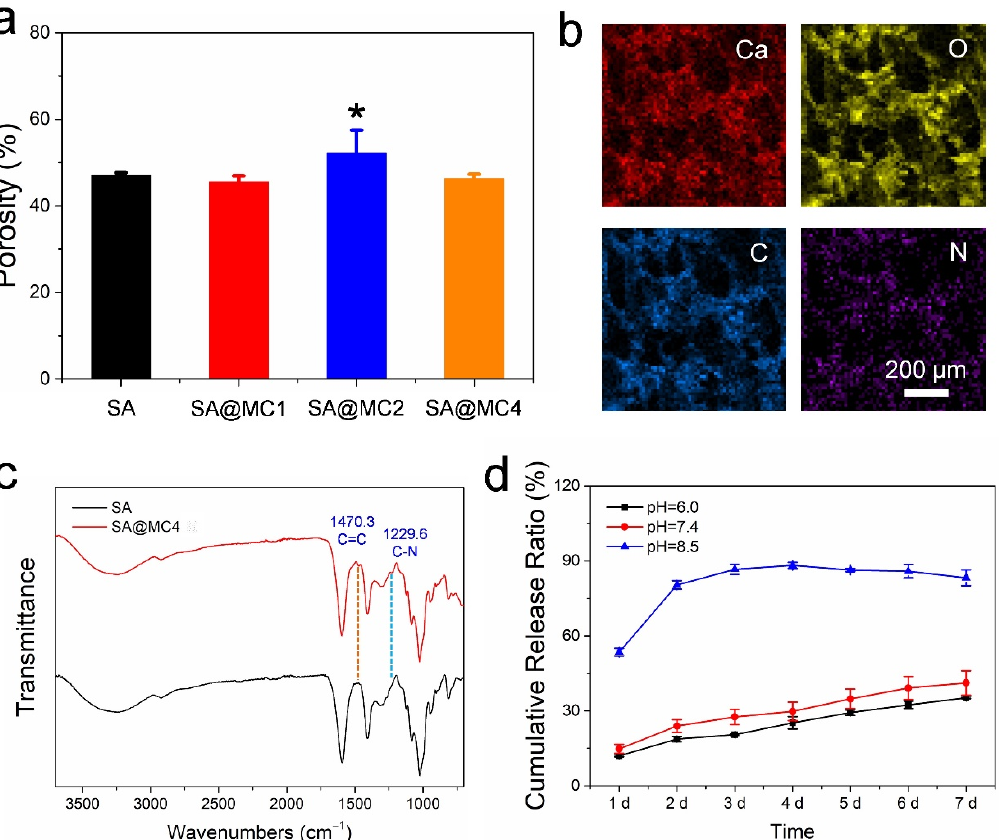
Figure 3. ( a ) The porosity of SA@MC injectable hydrogels at different concentrations of MC; ( b ) element mapping of SA@MC4 injectable hydrogel; ( c ) FT-IR spectra of SA and SA@MC4 injectable hydrogels; ( d ) Release profiles of SA@MC4 injectable hydrogel at different pH values. * p < 0.05 vs. the control group .